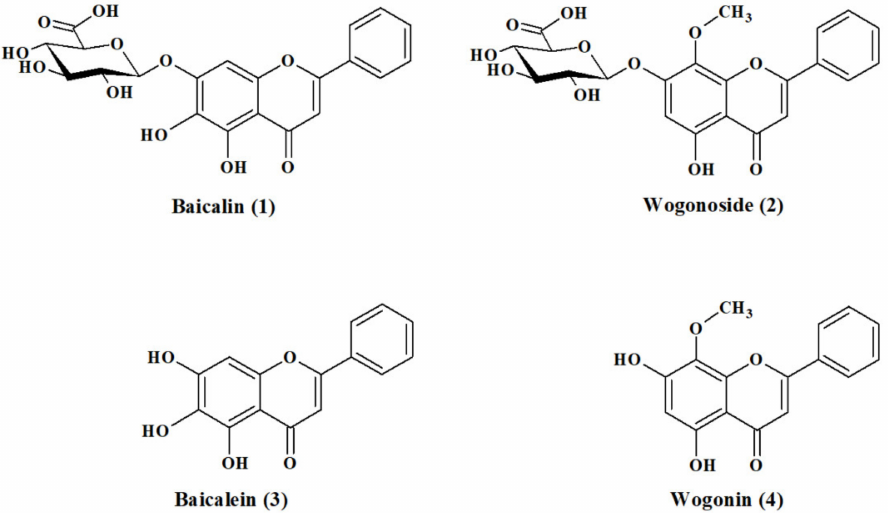
Figure 1. The chemical structures of the major bioactive flavones in Radix Scutellariae (Skullcap